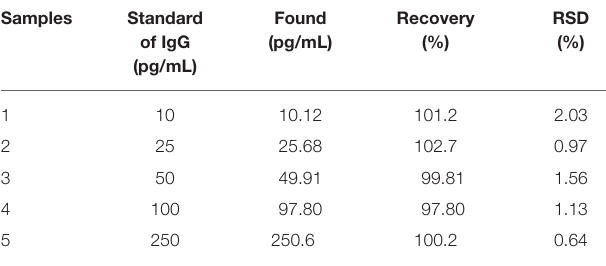
TABLE 2 | Recovery study of IgG in serum sample using the prepared immunosensor.